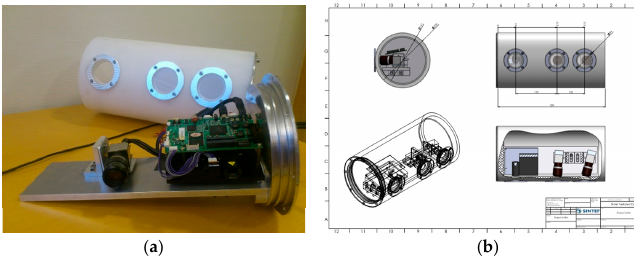
Figure 1. ( a ) Camera (right) and projector (left) mounted on an aluminium plate. Housing in the back. ( b ) Underwater housing overview and